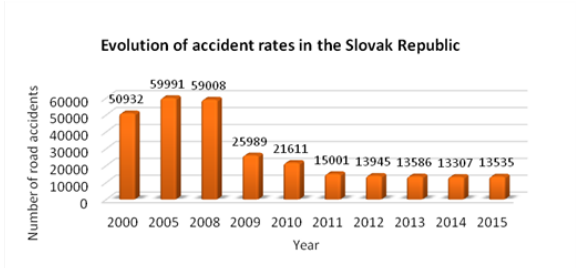
Figure 1. Evolution of accident rates in the Slovak Republic from 2000 to 2015.